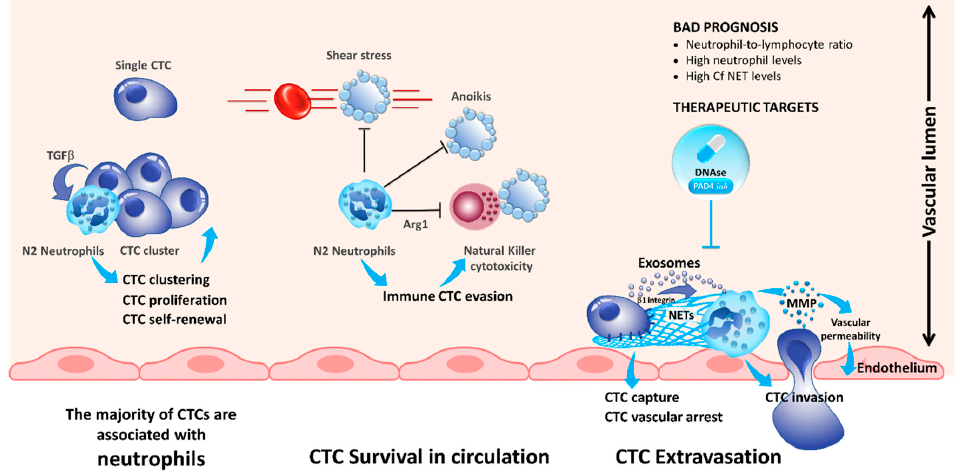
Figure 1. Compelling evidence indicates that blood neutrophils can offer proliferative and survival advantages to circulating tumor cells (CTCs) during their journey in the blood stream, rendering them more competent for metastasis development. Tumor-derived inflammatory factors strongly stimulate neutrophils to extrude chromatin webs called “neutrophil extracellular traps” (NETs). NETs, in turn, provide a niche to CTCs, arrest CTCs rolling, and promote metastasis. As such, understanding interaction of inflammatory N2 neutrophils with CTCs provides new potential therapeutic targets for disrupting these deadly metastatic seeds. As an example, blockade of NET formation using peptidylarginine deiminase 4 (PAD4) pharmacologic inhibitor or DNAse may decrease